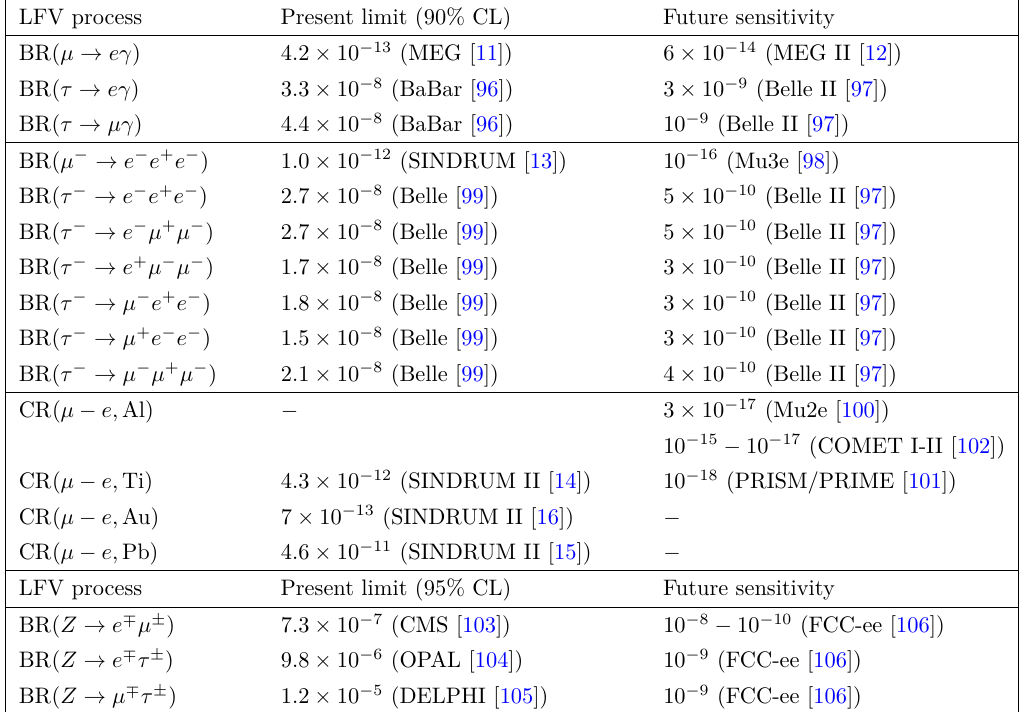
Table 8 . Current experimental bounds and future sensitivities for the branching ratios (BRs) and capture rates (CRs) of cLFV